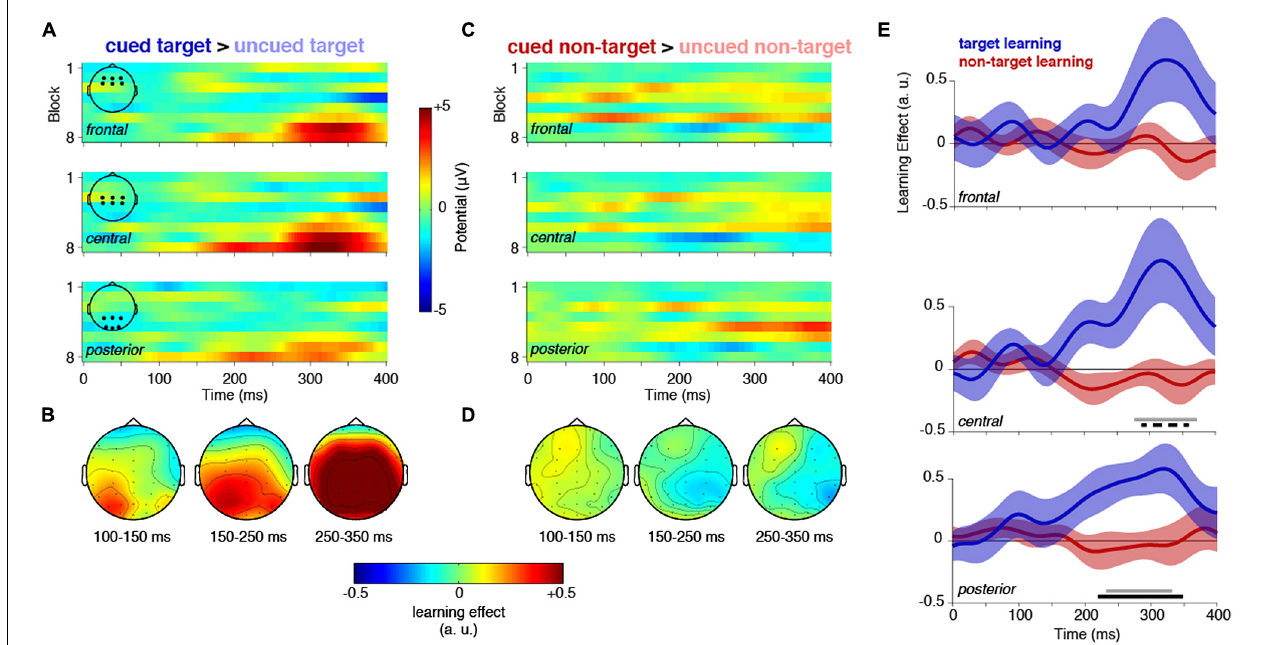
non-target stimulus. (E) The mean regression slope across the eight task blocks (fit separately at each time point) is shown for the same frontal, central, and posterior ROIs shown in (A) and (C) , for targets (blue lines) and non-targets (red lines). Shading indicates the standard error of the means (SEM). Horizontal bars indicate significant regression slopes in the target learning condition compared to chance (in black; central: p = 0.053, cluster-corrected, dashed line, posterior: p = 0.0130, cluster-corrected, solid line), and directly compared to the control non-target condition (in gray; central: p = 0.026; posterior: p = 0.045, cluster